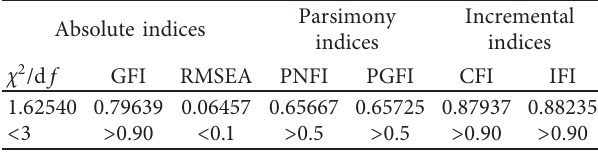
Table 8: Modified model fitting index of internal